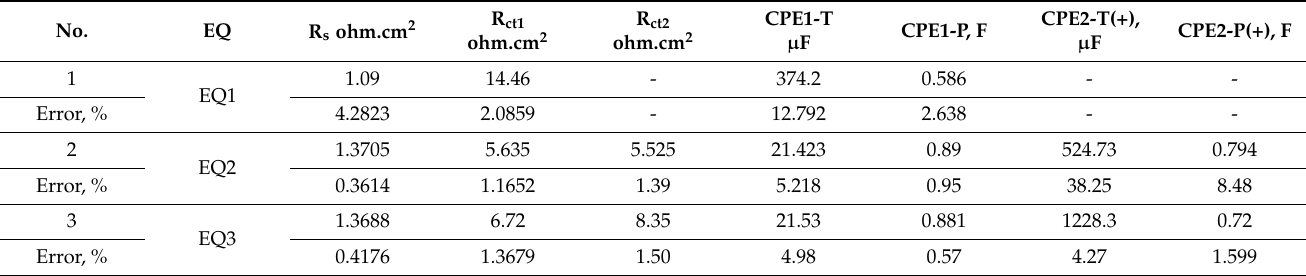
Table 1. Electrochemical impedance parameters found after EIS fitting using different equivalent circuits (Figure